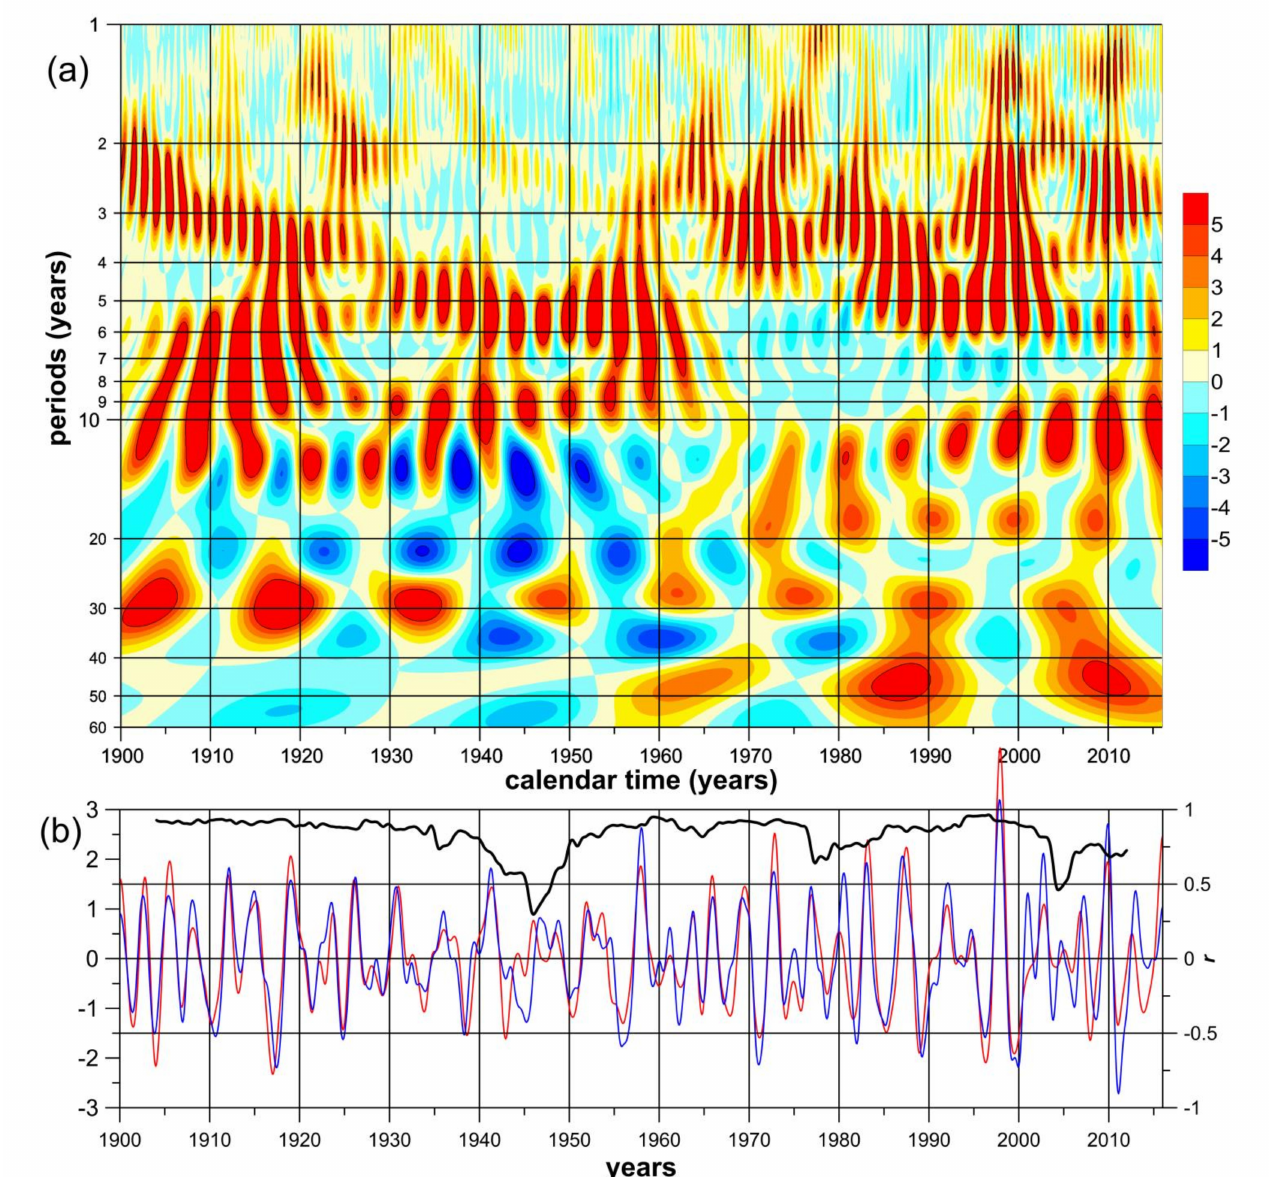
Figure 2. Diagram of the cross-wavelet transformation of the El Niño index (EONI) and the Global Atmospheric Oscillation index (GAO2) ( a ). Time series of EONI (red line) and GAO2 (blue line) with band-pass filtering from 2 to 7 years and sliding cross-correlations between them with a window of 8 years (black line) ( b